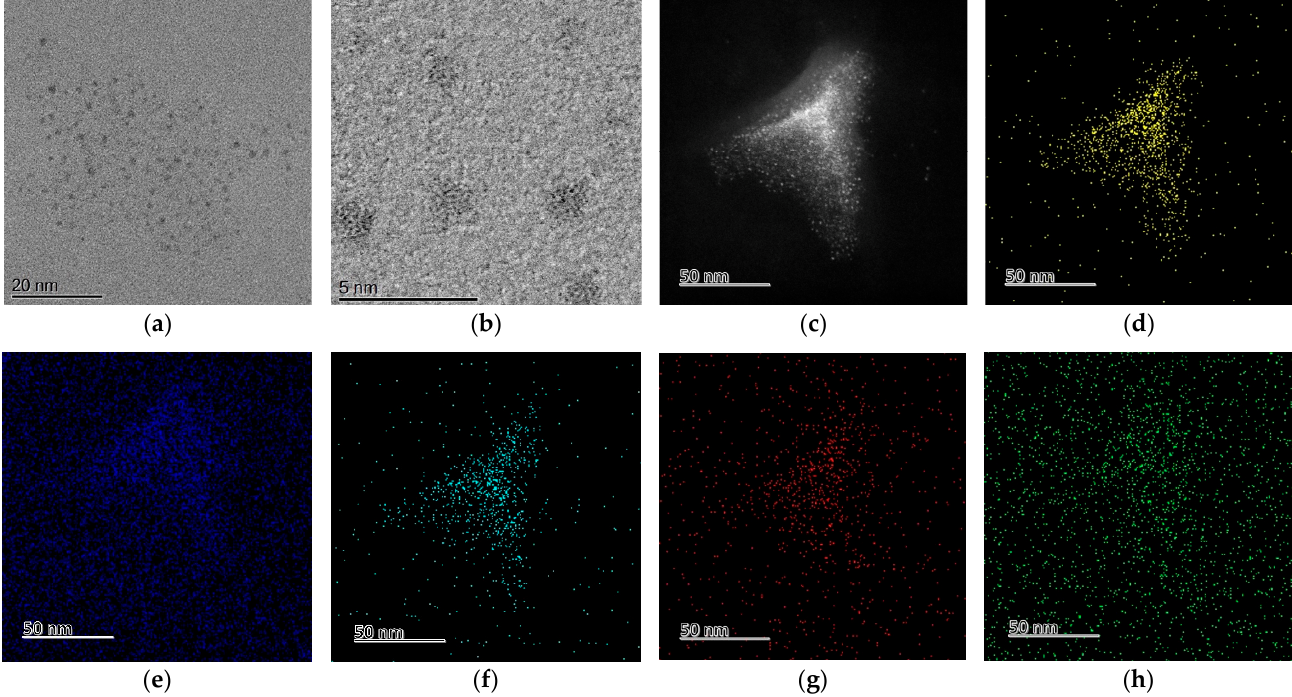
Figure 3. Thermogravimetric analysis of a sample of functionalized AuNP powder.